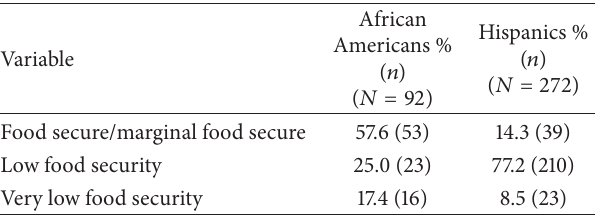
Table 3: Levels of food security among African American and Hispanic women.